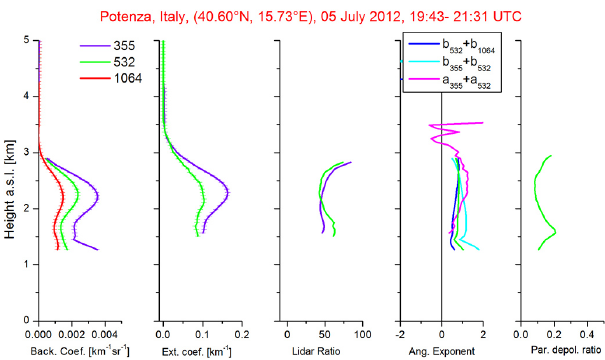
Figure 5. Example of aerosol optical properties vertical profiles re- trieved by a an EARLINET core station. The error bars report the statistical error on the retrieved